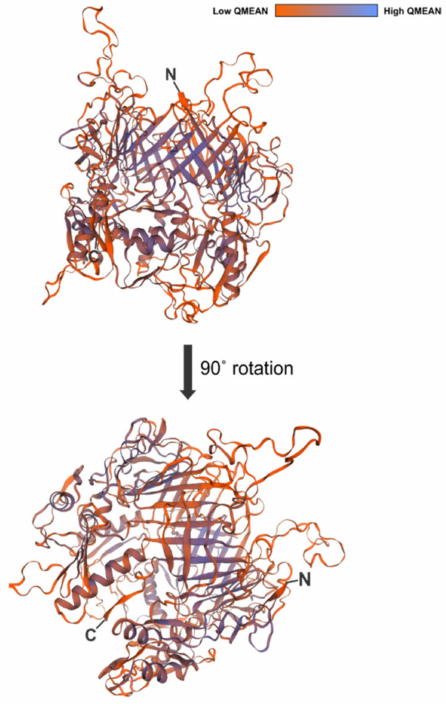
Figure 3. Predicted protein model of Gp4.SWISS-MODEL generated protein model for Gp4 with the absolute quality estimates (QMEAN) colorimetrically displayed. The prophage MuSo2 tail protein from Shewanella oneidensis (PDB ID 3CDD) was used as a template. The global model quality estimate (GMQE) was 0.46 while the sequence identity was 20.24%. The model encompassed 374/454 amino acids. N, N terminus; C, C